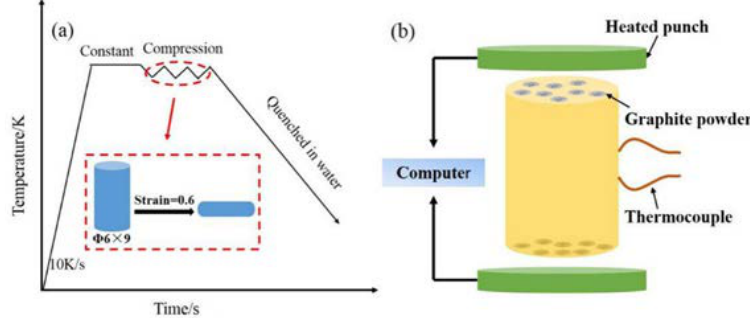
Figure 2. Schematic illustration of experimental procedure ( a ) and experimental device ( b ).